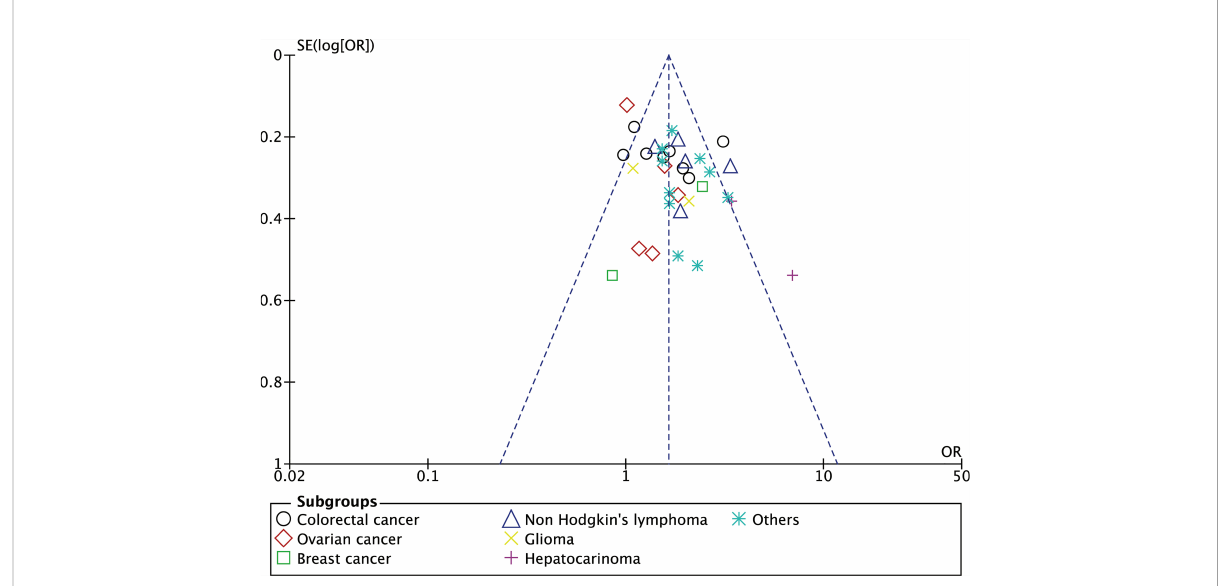
FIGURE 4 The funnel plot showing the OR of individuals studies against the standard error of the OR to detect bias and heterogeneity of between